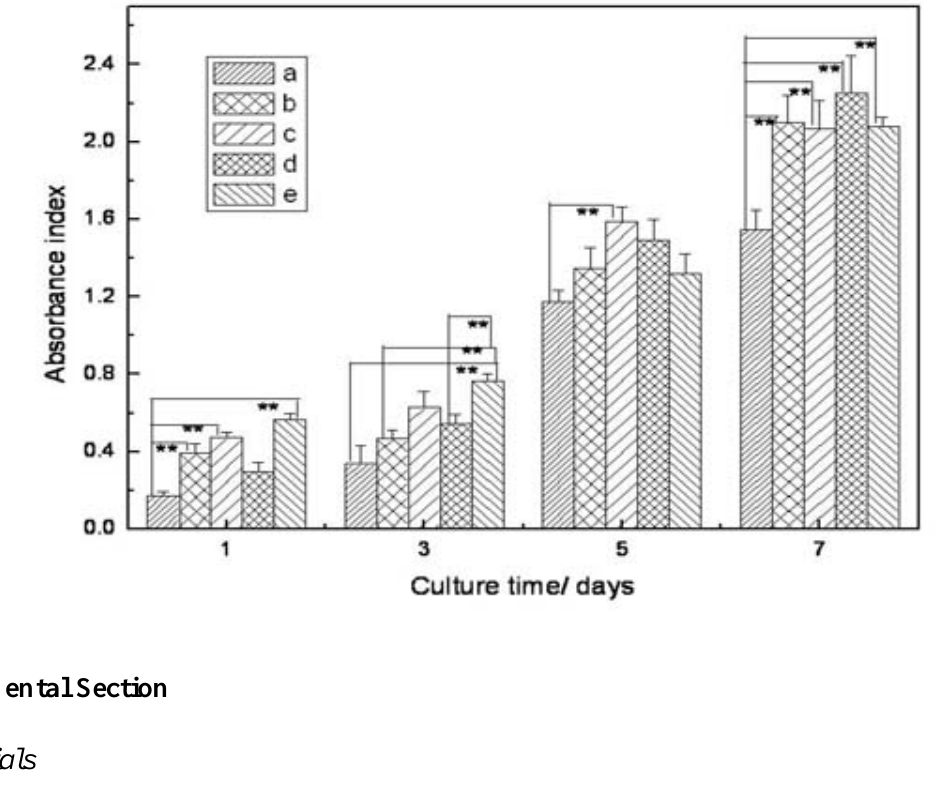
Figure 5. Comparison of fibroblasts proliferation on electrospun silk fibroin–chitosan nanofibers and controls: ( a ) glass cover slips; ( b ) CS/SF (80/20); ( c ) CS/SF (50/50); ( d ) CS/SF (20/80); ( e ) pure SF. Error bars represent mean ± SD for n = 3. **p <